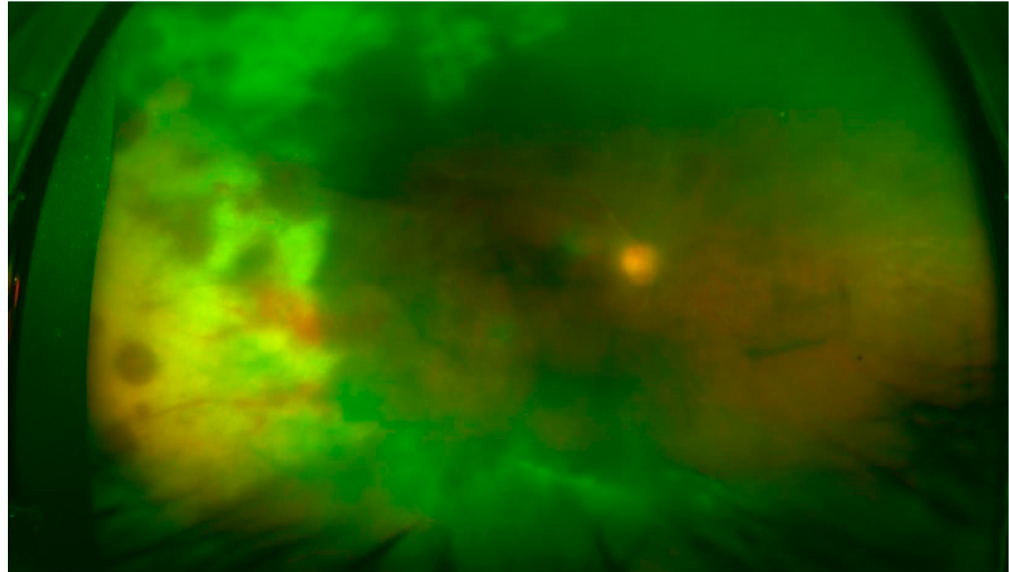
Figure 6. Ultrawide-field imaging of a patient with varicella zoster-related acute retinal necrosis. The fundus photograph reveals extensive peripheral retinal necrosis resulting in whitening and edema, along with retinal arteritis. There is significant media haze due to the presence of vitreous inflammation and cells.